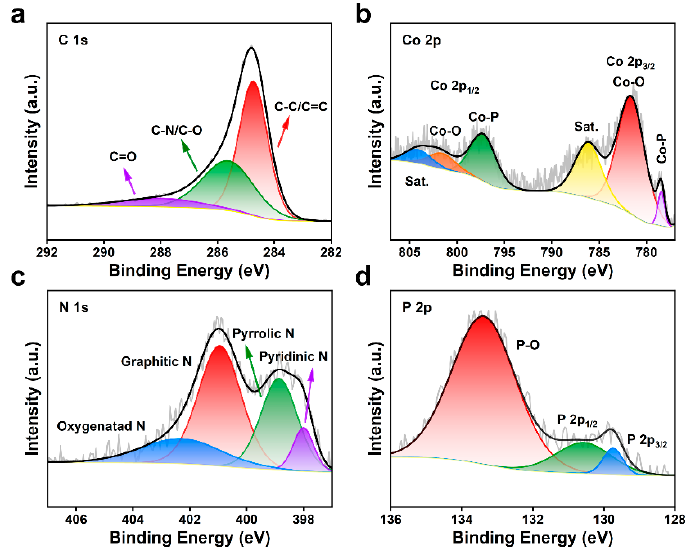
Figure 4. High-resolution XPS spectrum ( a ) C 1s, ( b ) Co 2p, ( c ) N 1s and ( d ) P 2p of Co 2 P@N-C-900.